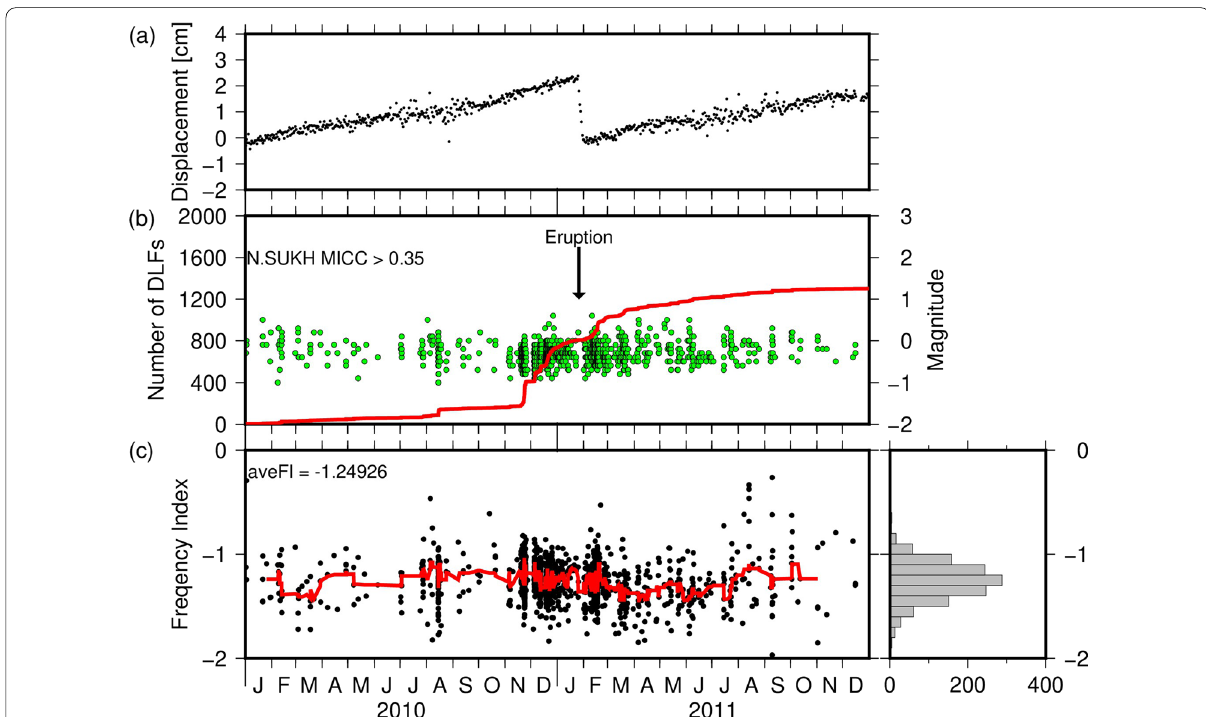
Fig. 3 Geodetic and DLF earthquake observations in the Kirishima volcanic complex during the 2010–2011 period. a Horizontal displacement at Ebino GNSS station relative to Makizono (see Fig. 1). b Cumulative number of DLF earthquakes (red line) and DLF earthquake magnitudes (green circles). c Frequency index (FI) of the DLF earthquakes. The median FI value (red line) is based on a moving window of 15 events. The right panel shows the FI frequency